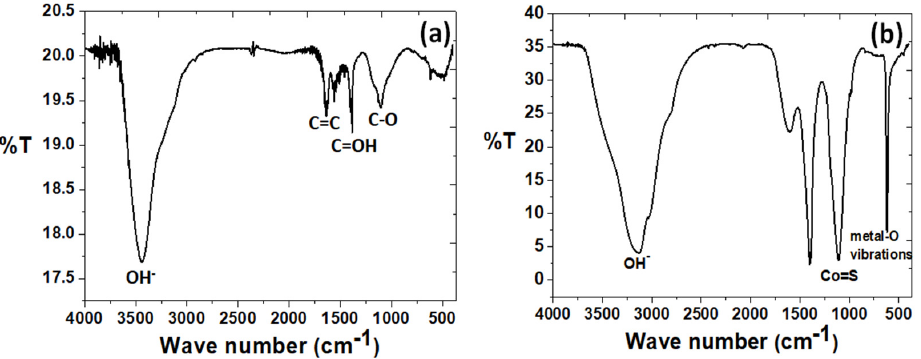
Figure 1. FT–IR spectra of rGO/oxdCNT ( a ) and (NiCo)–S@rGO/oxdCNT ( b ) powders.